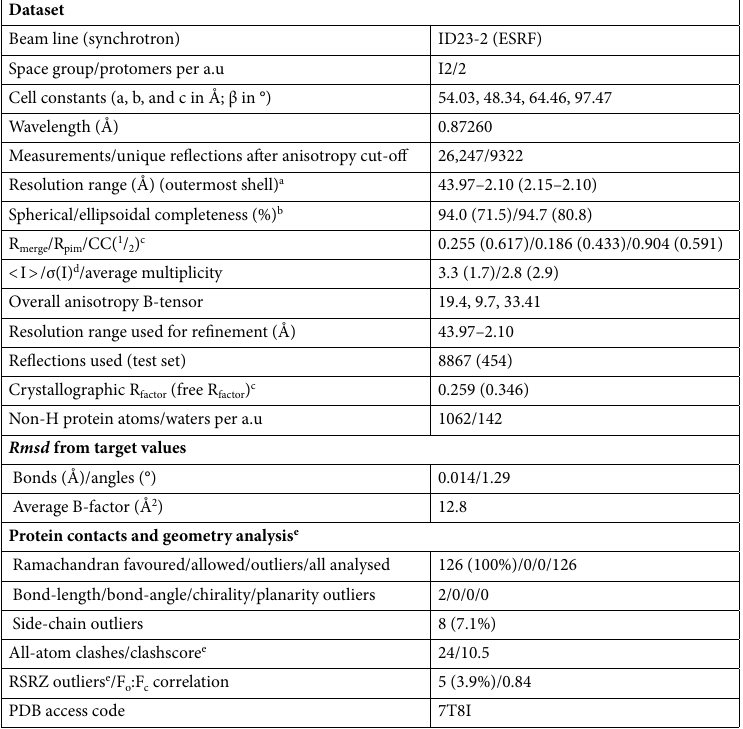
Table 1. Crystallographic data. a.u. asymmetric unit, rmsd root-mean square deviation, RSRZ real-space R-value Z-score. a Values for data processing in parenthesis refer to the outermost resolution shell if not otherwise indicated. b According to Mrfana within Staraniso 21 . c For definitions, see 22 . d < I > /σ(I) of unique reflections after merging according to Mrfana . e According to the wwPDB Validation Service (https:// wwpdb- valid ation. wwpdb. org/ valid servi